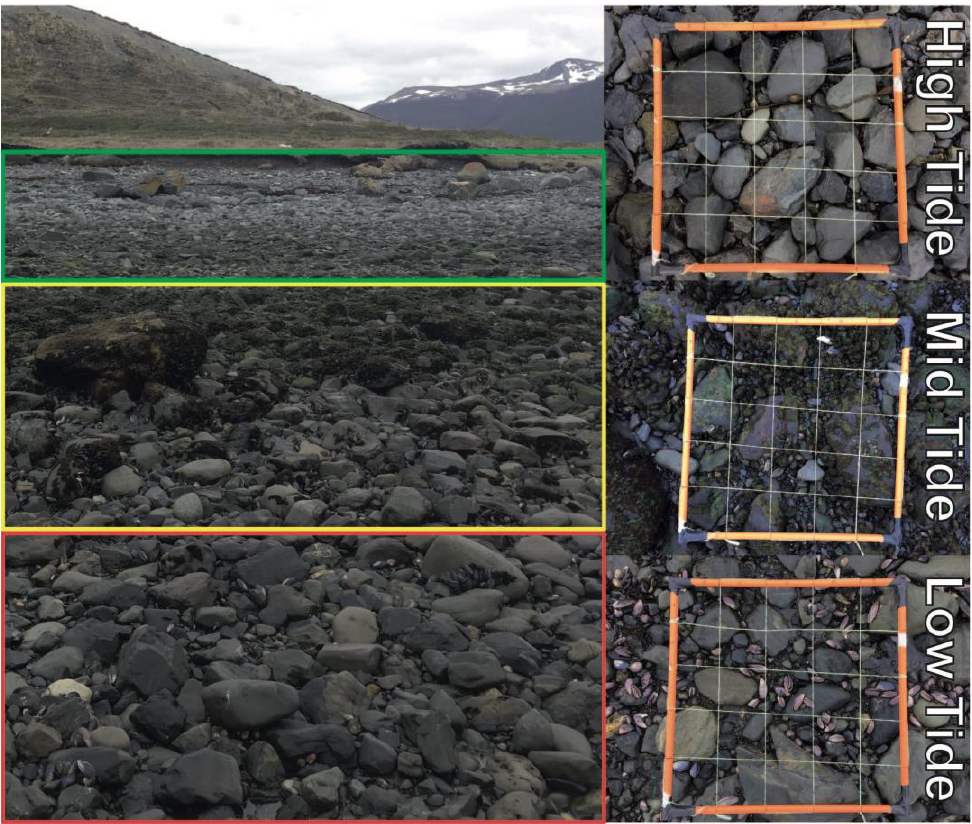
Figure 4. The three tidal areas in Róbalo Bay, with the representative quadrats (60 cm × 60 cm) used for habitat characterisation.